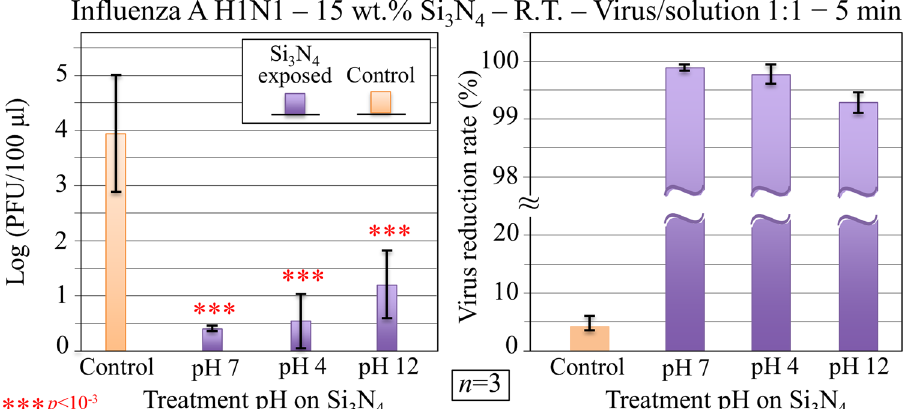
Figure 5. Immunochemistry results collected on MDCK cells infected with Influenza A H1N1 virus exposed for 5 min to aqueous solution containing 15 wt.% Si 3 N 4 powder at room temperature. Data are plotted (with statistical validation) in logarithmic scale as PFU counts and virus reduction rate as a function of the pH of a 48 h autoclave pre-treatment of Si 3 N 4 powder at 210 °C. Control samples refer to virions embedded for 5 min in aqueous environment in absence of the Si 3 N 4